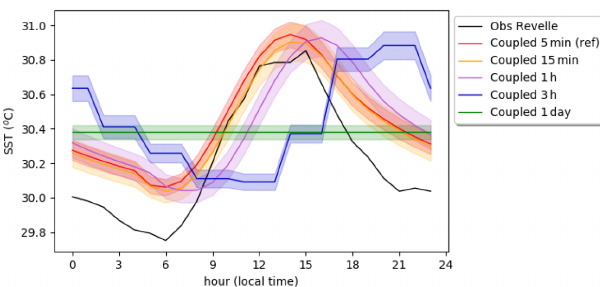
Figure 13. Mean daily cycle of SST ( ◦ C) in sensitivity experiments to the coupling frequency averaged over the simulated period (13– 22 November). The shading represents 2 standard deviations of the inter-member